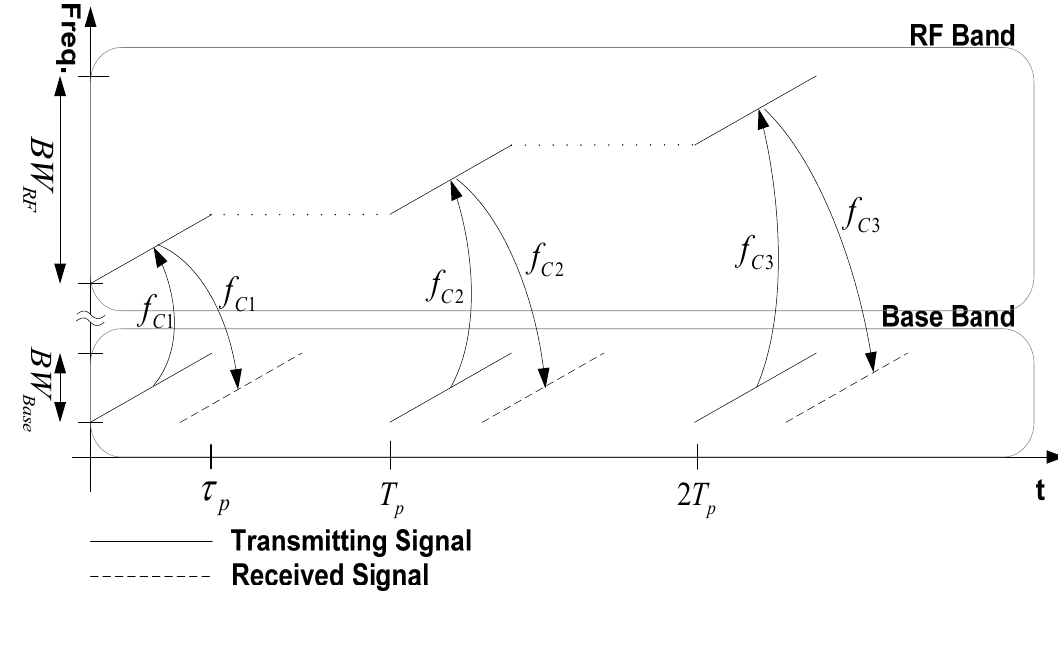
Figure 1. The Frequency up-down scheme of the synthetic wideband signals. T period, τ is pulse width, and f p